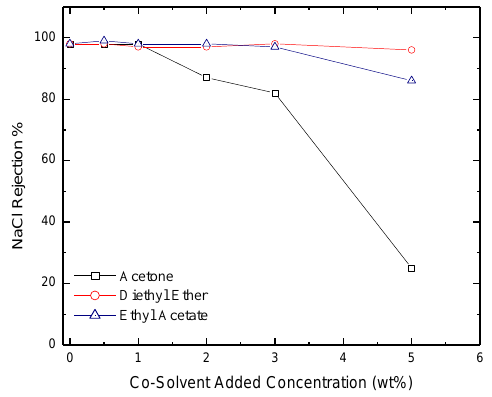
Figure 10. Salt rejection of IPA through membranes formulated with acetone, diethyl ether, and ethyl acetate added as co-solvents.